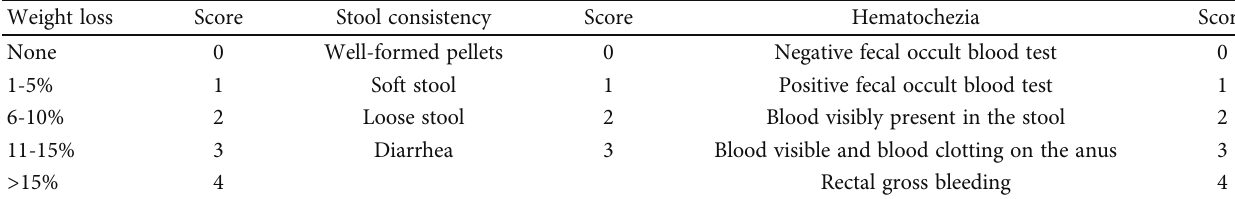
Table 1: Diseases activity index scoring.